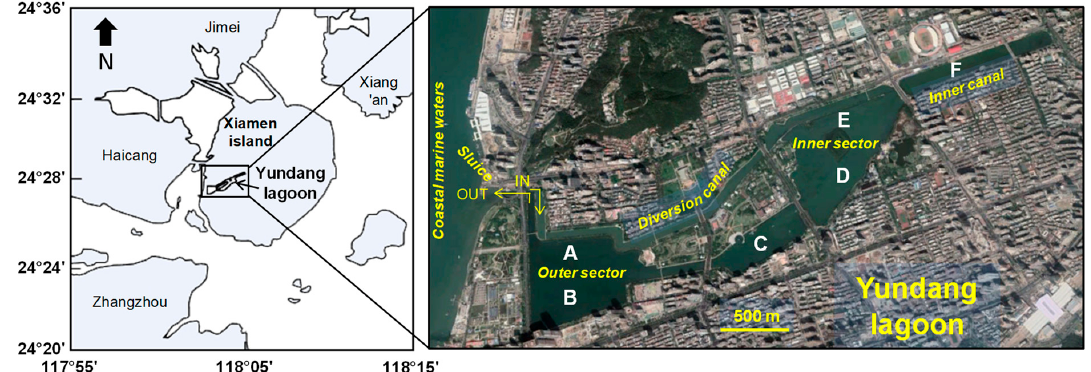
Figure 1. Location of the study area (Xiamen Island, Southeast China) and sampling sites (sites A–F) in the Yundang Lagoon. A schematic representation of water circulation in the Yundang Lagoon is given in [34].